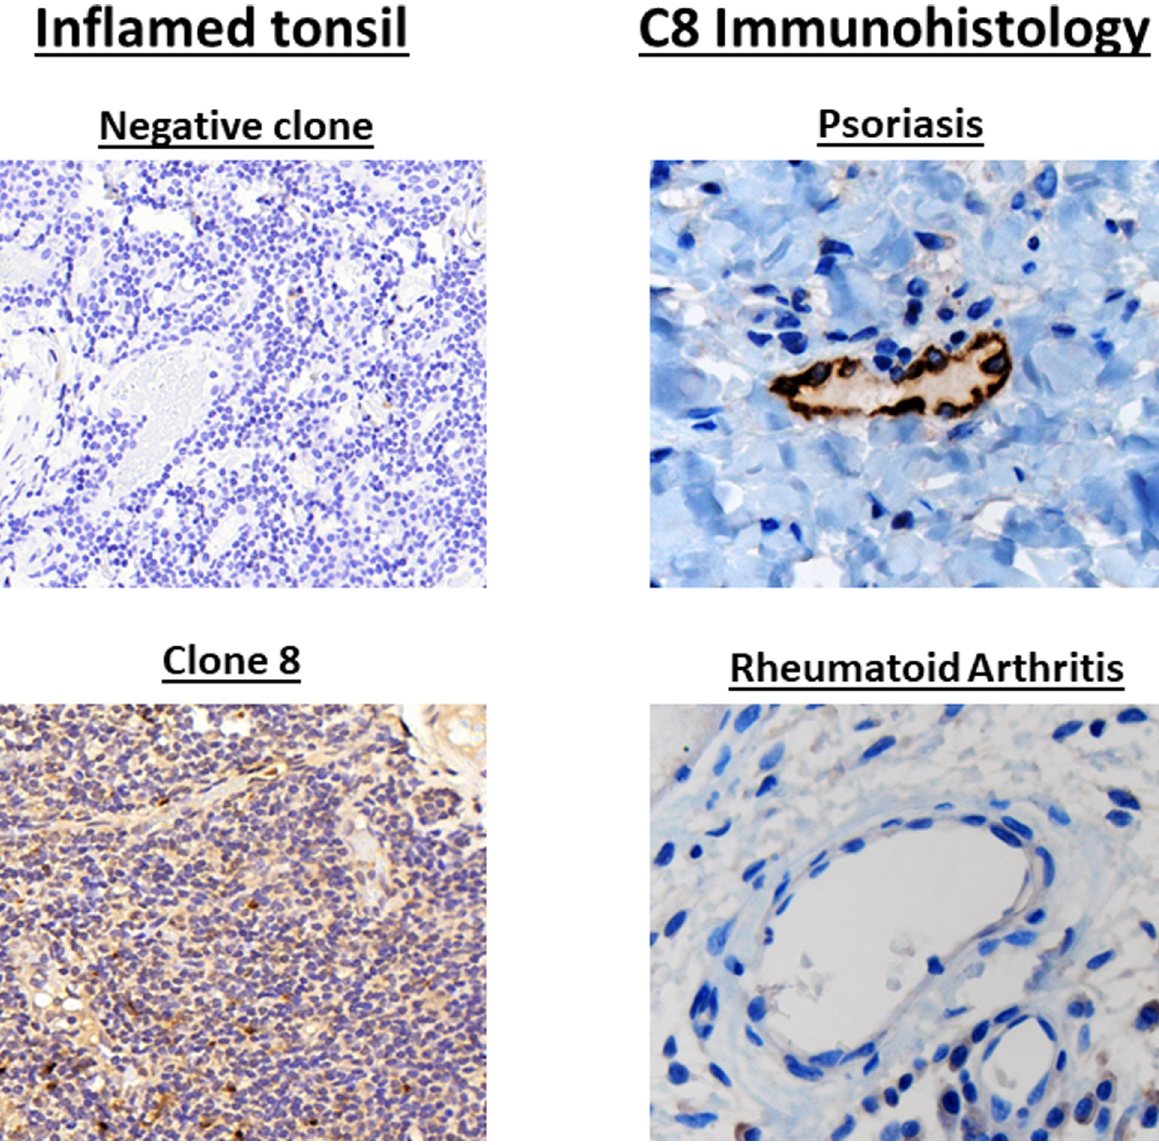
Fig 4. Screening of C8 for immunohistologic recognition of CCL21 in a tonsilar lymphoid biopsy specimen. Screening for binding of CCL21 in human lymphoid tissue. C8 was positive for binding to appropriate CCL21-expressing cells in human tonsil lymph node, while another monoclonal antibody in this series that failed screening in Fig 1 did not bind to any cells, indicating the utility of C8 as an immunohistologic tool (left panels). CCL21 is expressed in the venule endothelium of T-cell-mediated auto-immune skin diseases [15]. C8 specifically recognizes this expression in immunohistologic assays while it did not recognize synovium from rheumatoid arthritis serves as a negative control, as it is mediated by a distinct immunologic pathway (right panels).